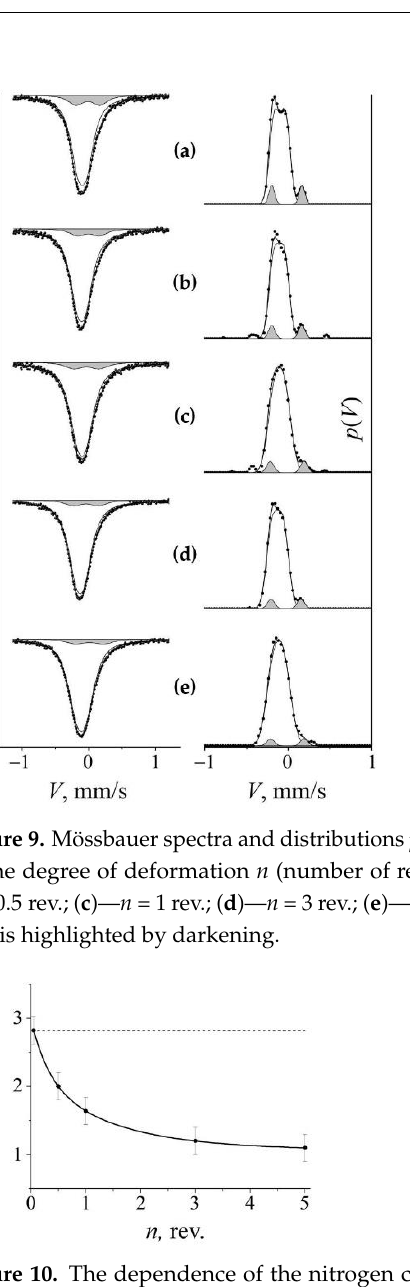
Figure 10. The dependence of the nitrogen content c (N) in the austenite matrix on the degree of deformation n (number of revolutions n ) by the HPT at 573 K of the quenched FeMn 22 Cr 18 N 0.83 steel. The dotted line indicates the nitrogen content in the quenched steel.